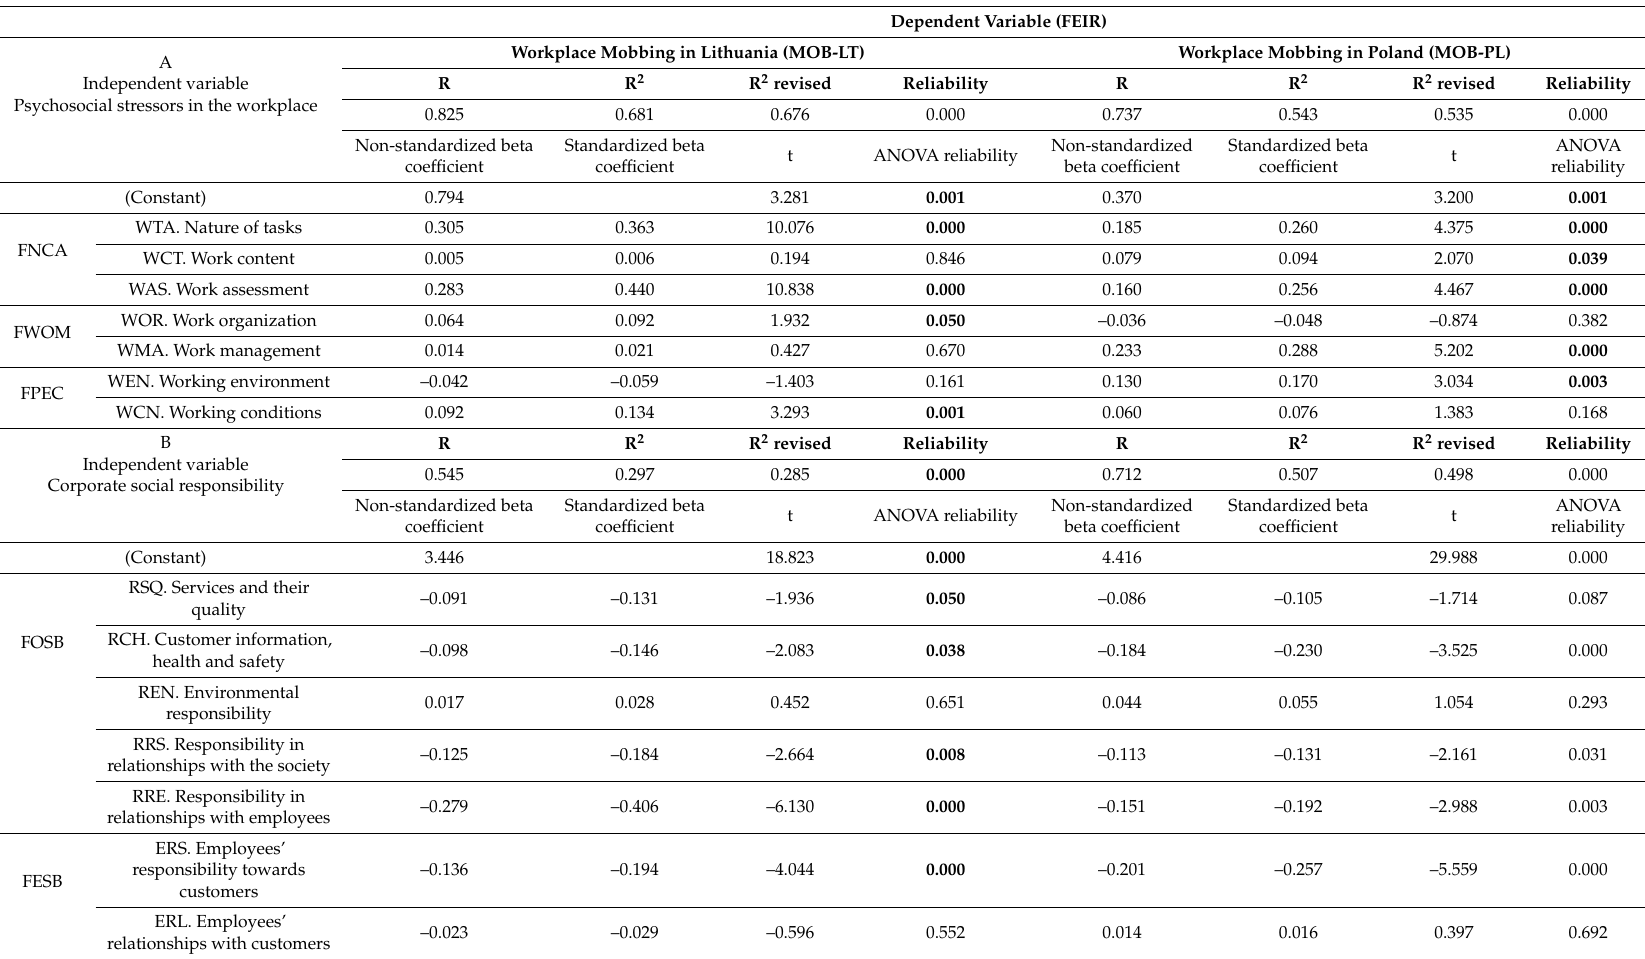
Table 7. Workplace mobbing in Lithuanian and Polish organizations as a dependent